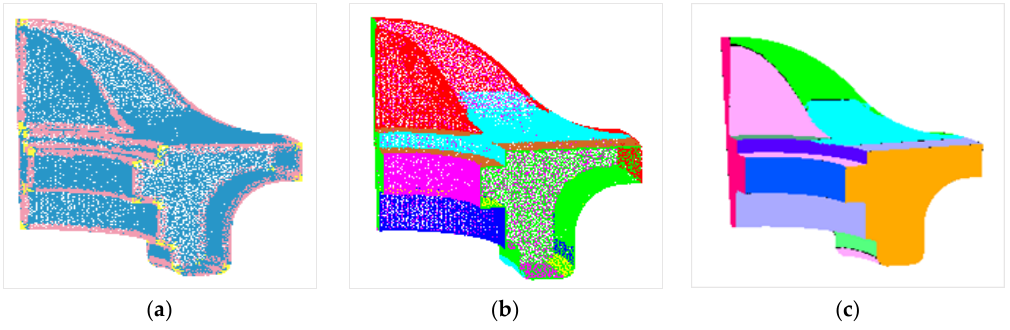
Figure 11. Experimental results of the fandisk model: ( a ) feature point segmentation; ( b ) feature surface extraction; ( c ) feature surface reconstruction.